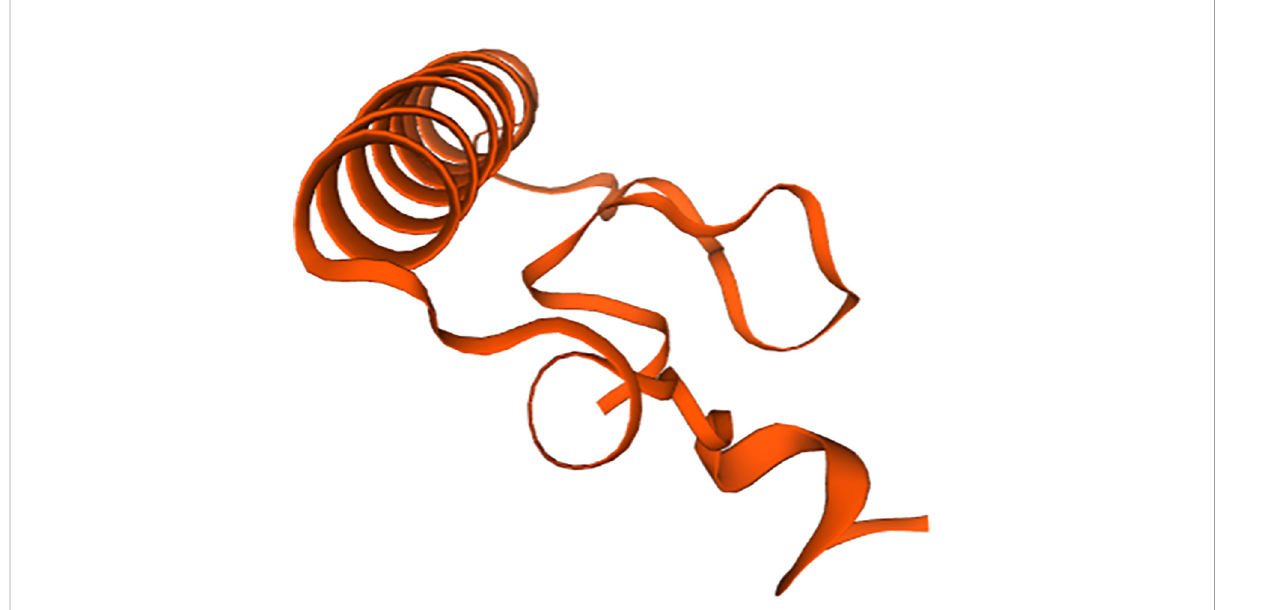
FIGURE 3 Prediction of the protein model of IFITM1